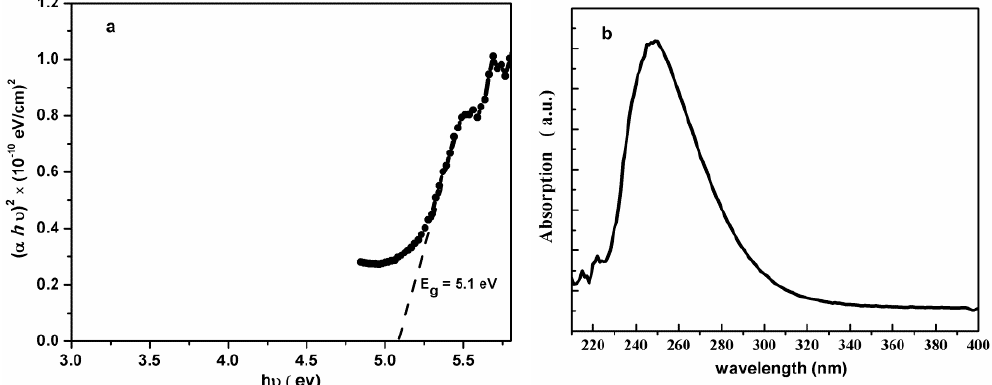
Figure 7. ( a ) Tauc plot of bandgap energy for AlN nanoparticles deposited on the glass substrate. ( b ) Absorption of AlN nanoparticles deposited on glass substrate.